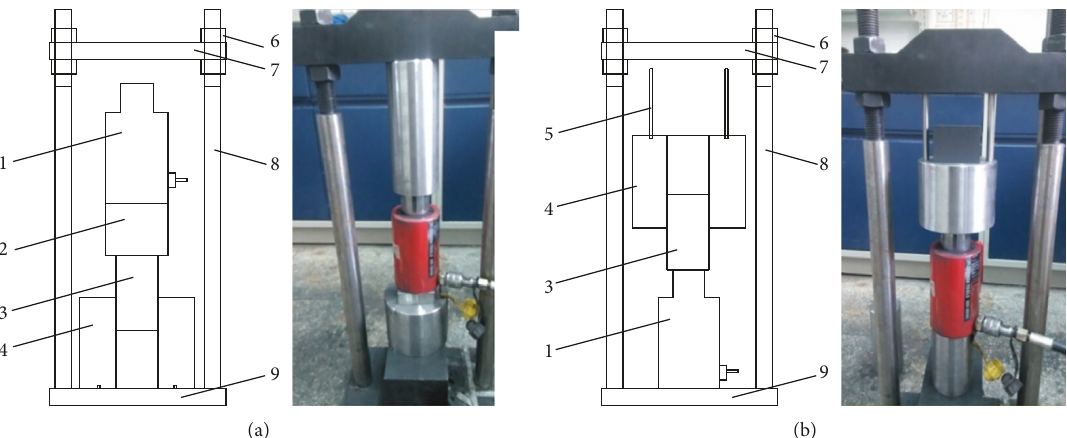
Figure 2: Briquette coal making device. (a) Pressing process and (b) demoulding process.1: loading parts; 2: loading column; 3: wiper block; 4: moulds; 5: demoulding column; 6: fixed nut; 7: pressure bearing roof; 8: support rods; 9: pedestal.